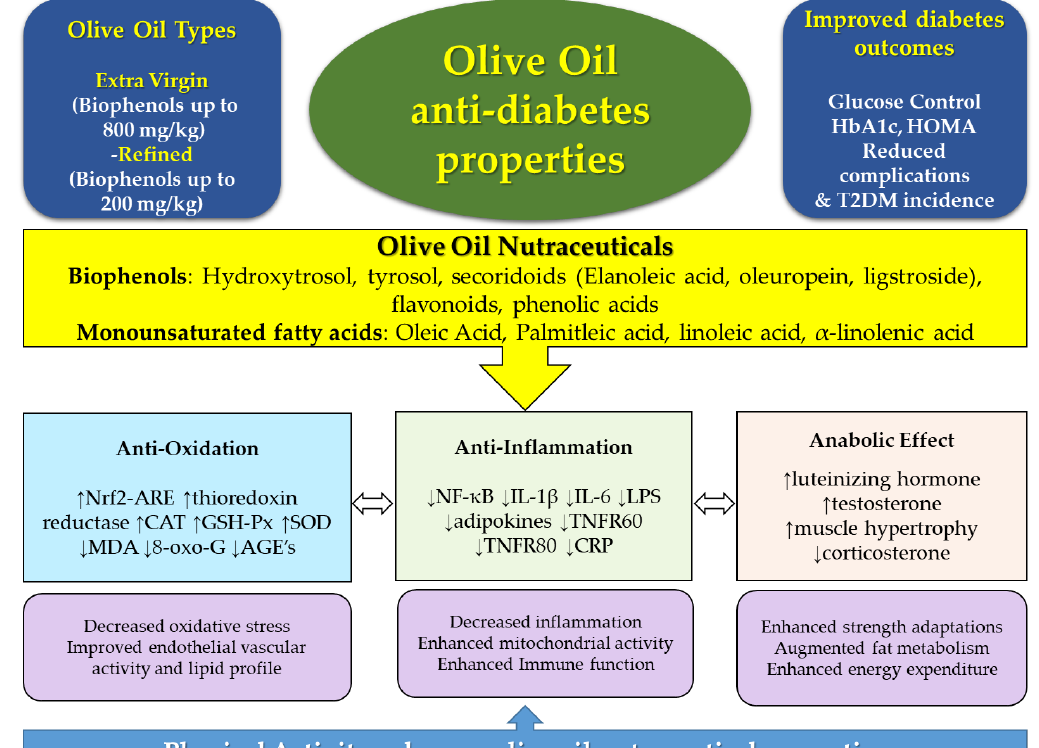
Figure 1. Olive oil, types, and phenolic compounds, and associated diabetes protective molecular mechanisms, which can potentially be augmented with physical activity. AGE’s: Advanced glycated